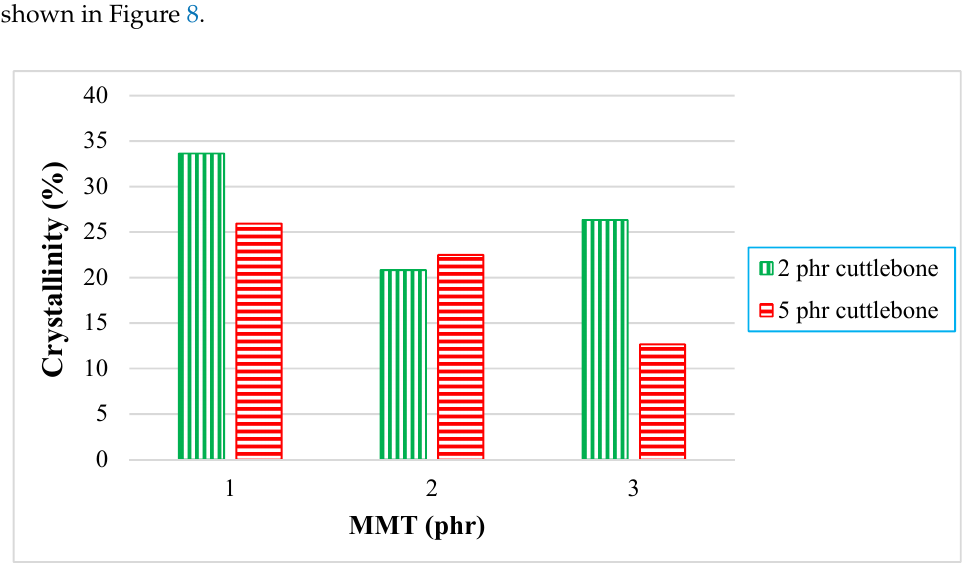
Figure 8. Crystallinity of PVOH-calcined cuttlebone-MMT composite.